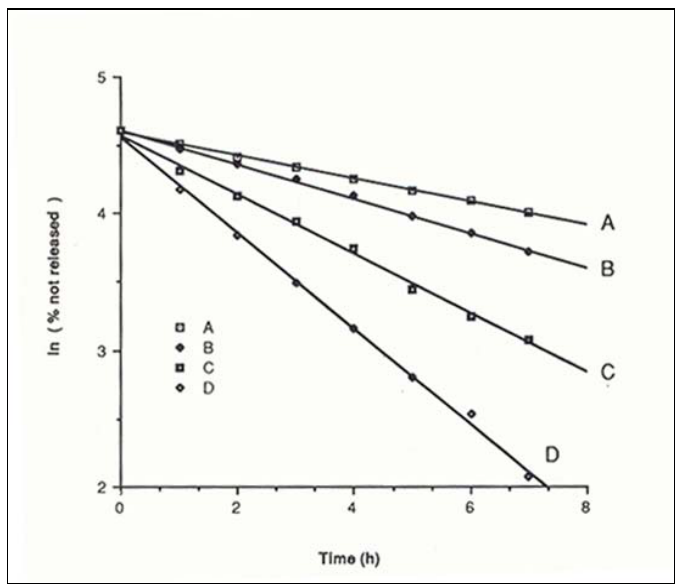
Figure 2. Release of TPH (A), Polystyrene sulphonate sodium salt (Mw=1500) (B), Benzamide (C) and Sodium salicylate (D) from Sclg tablets, plotted according to eq.